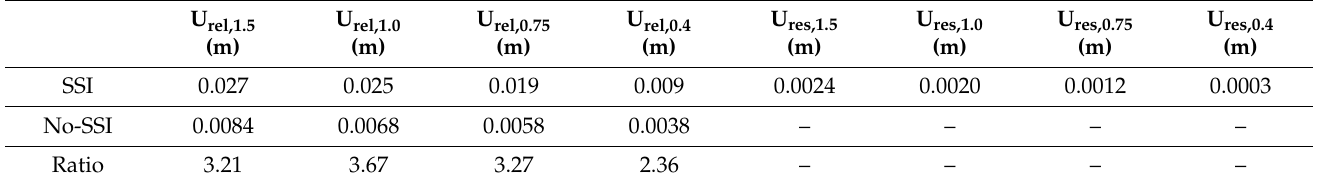
Table 3. Results obtained by the two models, considering and neglecting SSI, in terms of relative horizontal (U rel,k ) and residual (U res,k ) displacements of the pier, for the k seismic